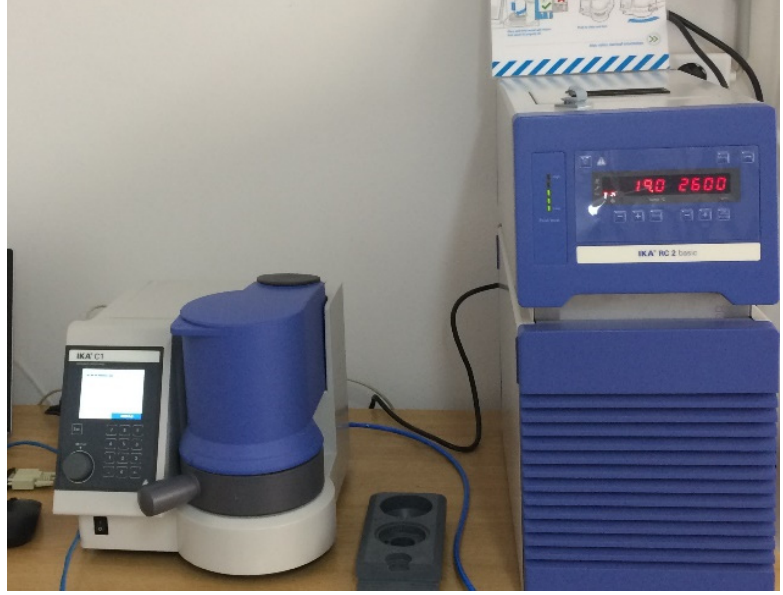
Figure 4. Calorimetric analysis for MSW sample.